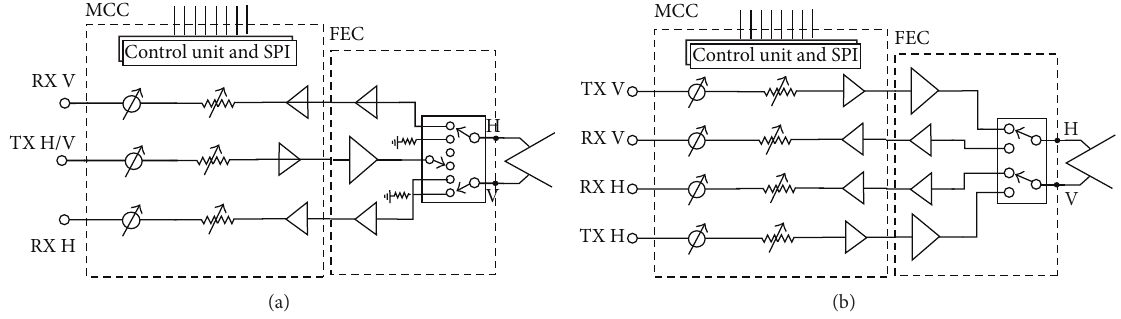
Figure 2: Dual-polarized 𝑇/𝑅 modules for polarimetric phased array weather radars. (a) is for the ATSR mode and (b) is for the STSR mode. In the ATSR mode, one channel is shared for transmitting 𝐻 and 𝑉 signals and two independent channels are used for reception. In the STSR mode, four independent channels, two for transmission, two for reception, and one 𝑇/𝑅 switch to commute the transmission and reception signals, are required.